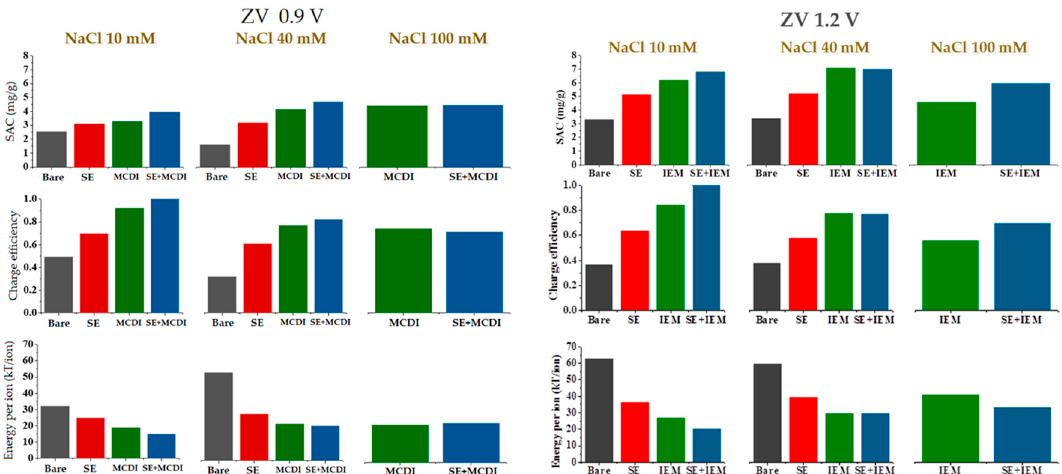
Figure 6. Salt adsorption, charge efficiency, and energy per ion removed calculated for electrode configurations under ZV desorption conditions for the adsorption cycle shown in Figure 4.